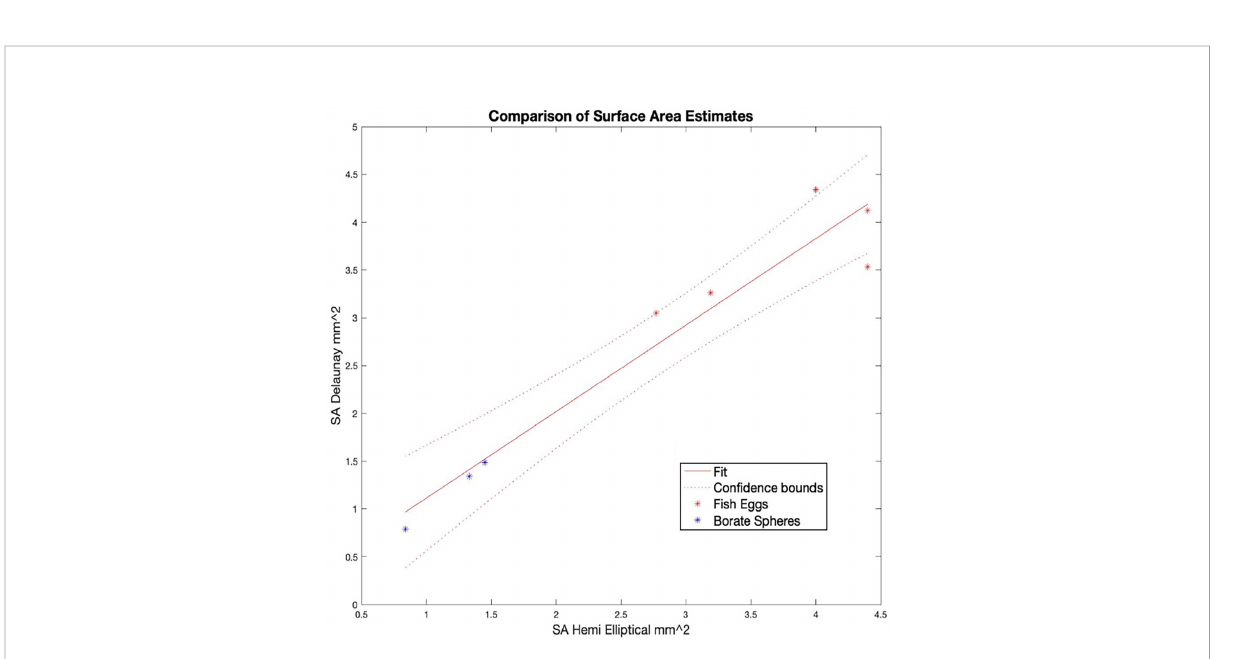
The “ x ” and “ y ” diameters were inferred from the observed contour of the lowest plane in the OCT data point cloud. Height was the distance from this plane to the top of the observed